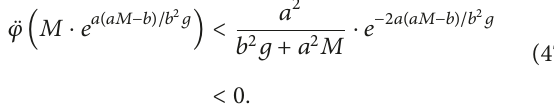
Figure 1: The image of the energy-Casimir mapping ( 𝑔 = 10, 𝑎 = 2, 𝑏 = 1